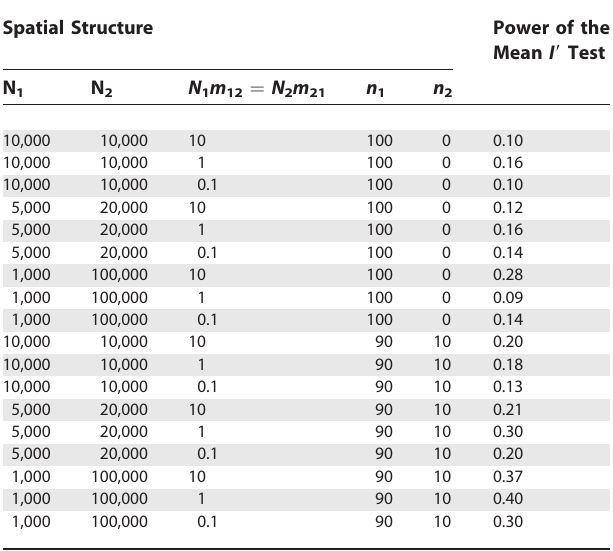
Table 2. The Power of the Mean I 9 Test to Detect Tree Imbalance under a Two-Island Model with Conservative Migration Spatial Structure Power of the